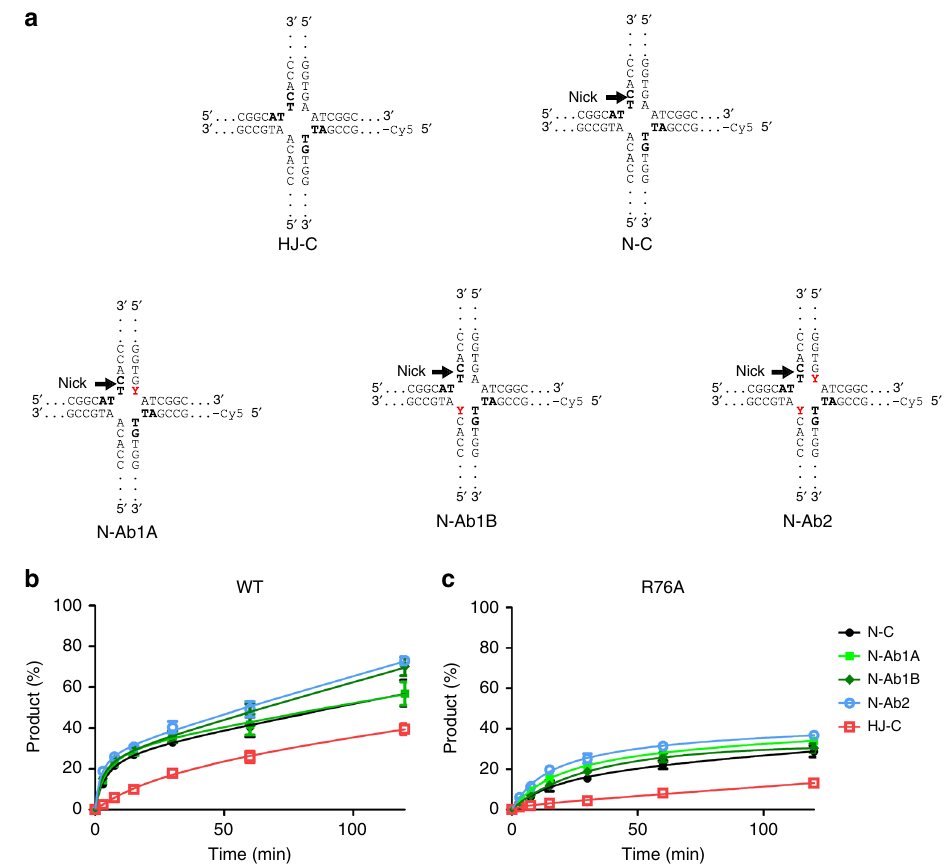
Fig. 5 Activity of Tt -RuvC on nicked substrates. a Schemes of HJs that were used in the experiment. The red Y indicates abasic sites. b , c Resolving activity of the Tt -RuvC ( b ) and R76A ( c ) variant on the control and nicked substrates. Data from three independent experiments were averaged and plotted for each timepoint. Error bars represent the standard deviation